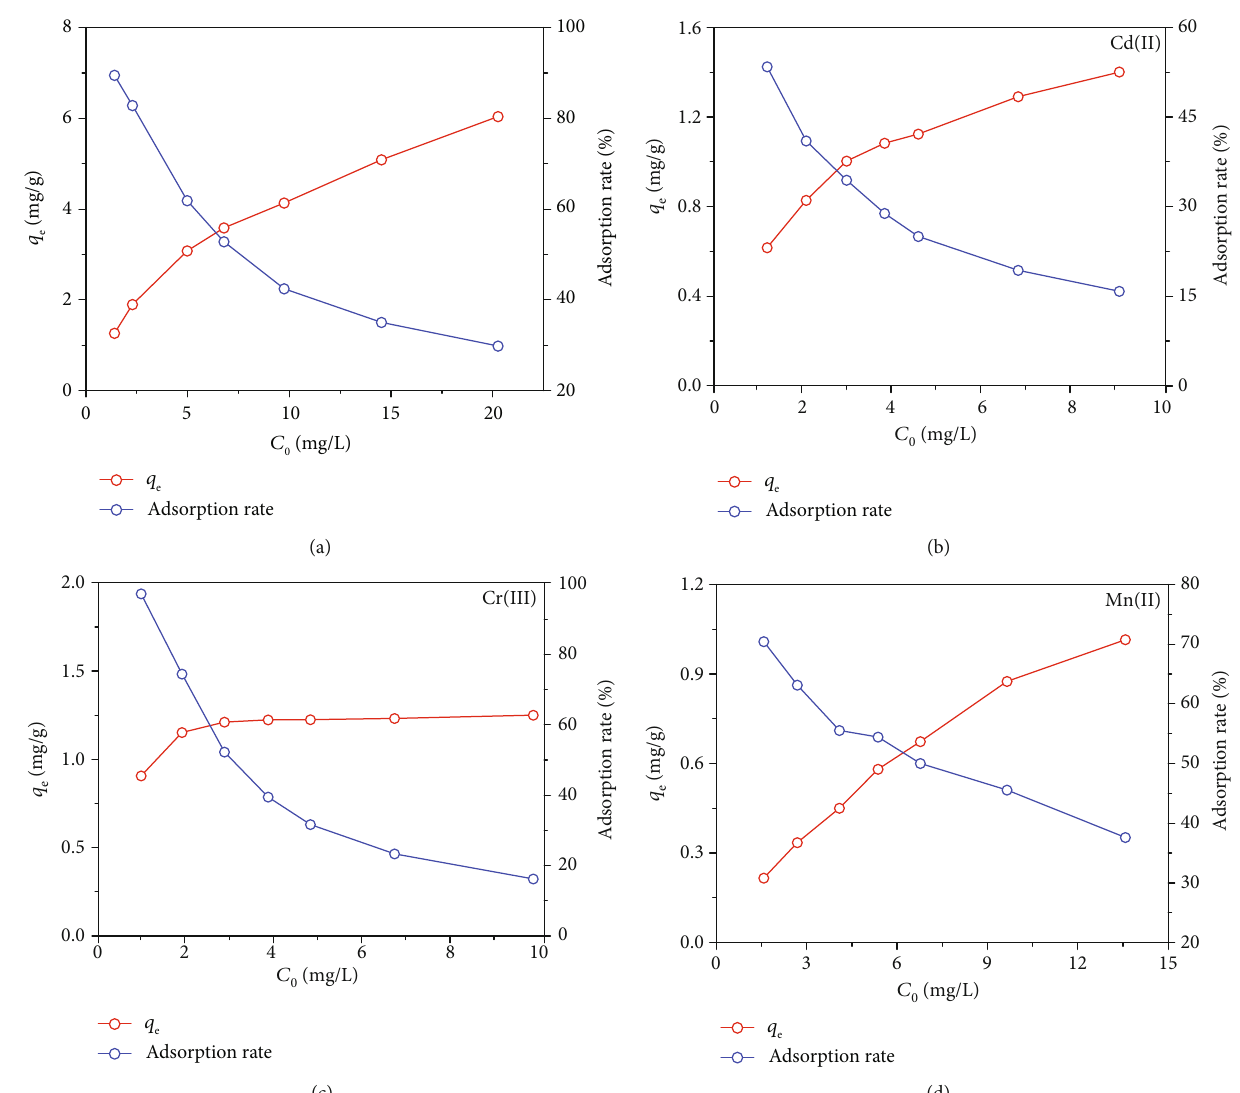
Figure 6: Adsorption capacity and adsorption rate of Pb(II), Cd(II), Cr(III), and Mn(II) on silty